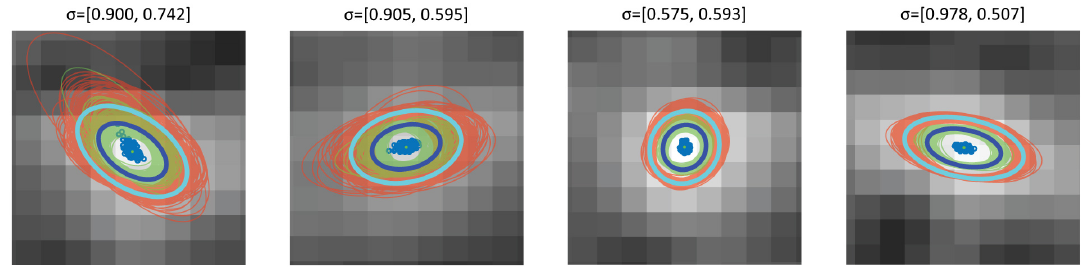
Figure 10. Examples of detected laser spot with uncertainty estimated through MC simulation for image shown in Figure 8. Individual detections and uncertainties are depicted with blue dots and red/green ellipses, while final uncertainty estimate is blue and